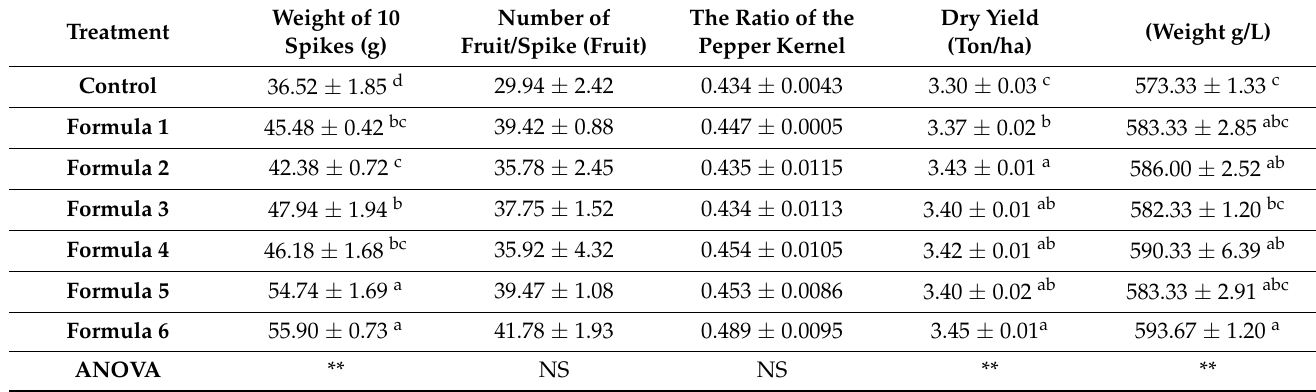
Table 8. Effect of bio-products on the yield and quality indices of peppercorn.